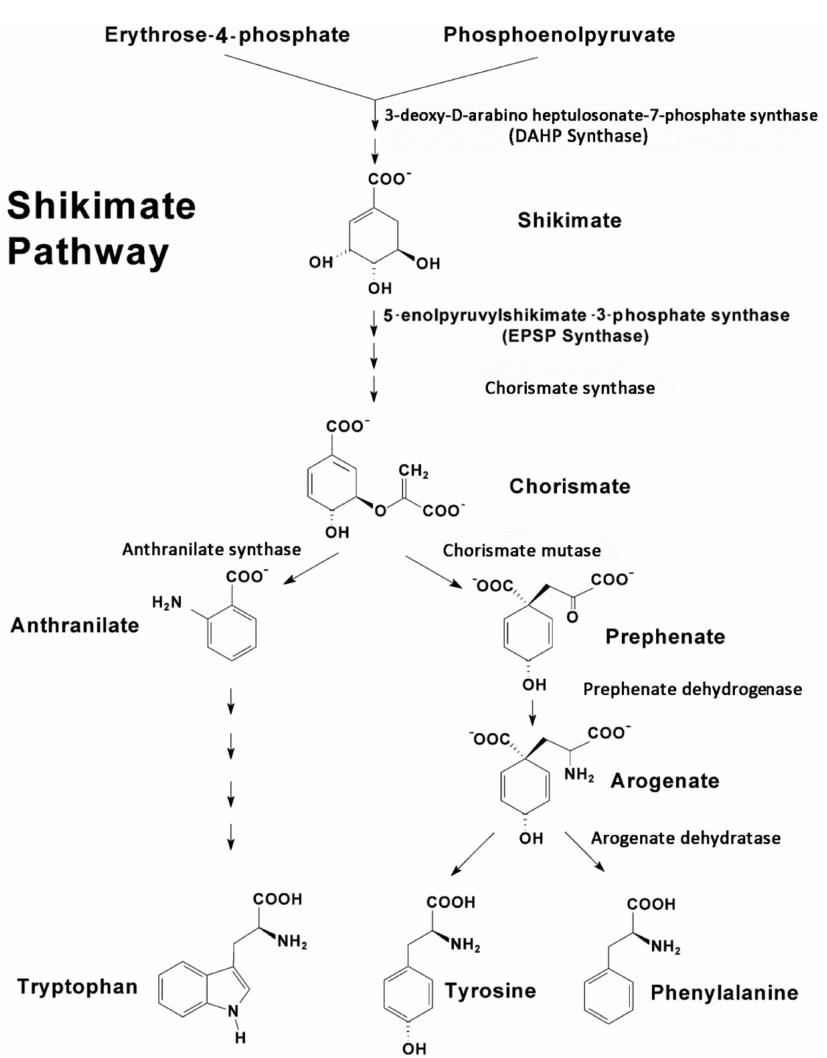
Figure 1. The shikimate pathway is comprised of several pathways that are controlled by several regulatory enzymes, including 3-deoxy-D-arabino-heptulosonate 7-phosphate synthase, chorismate synthase, chorismate mutase, prephenate dehydrogenase, arogenate dehydratase and anthranilate synthase, to name a few. Tyrosine and phenylalanine share a common branching pathway from chorismate through arogenate. Tryptophan derives from a separate branching pathway from chorismate through